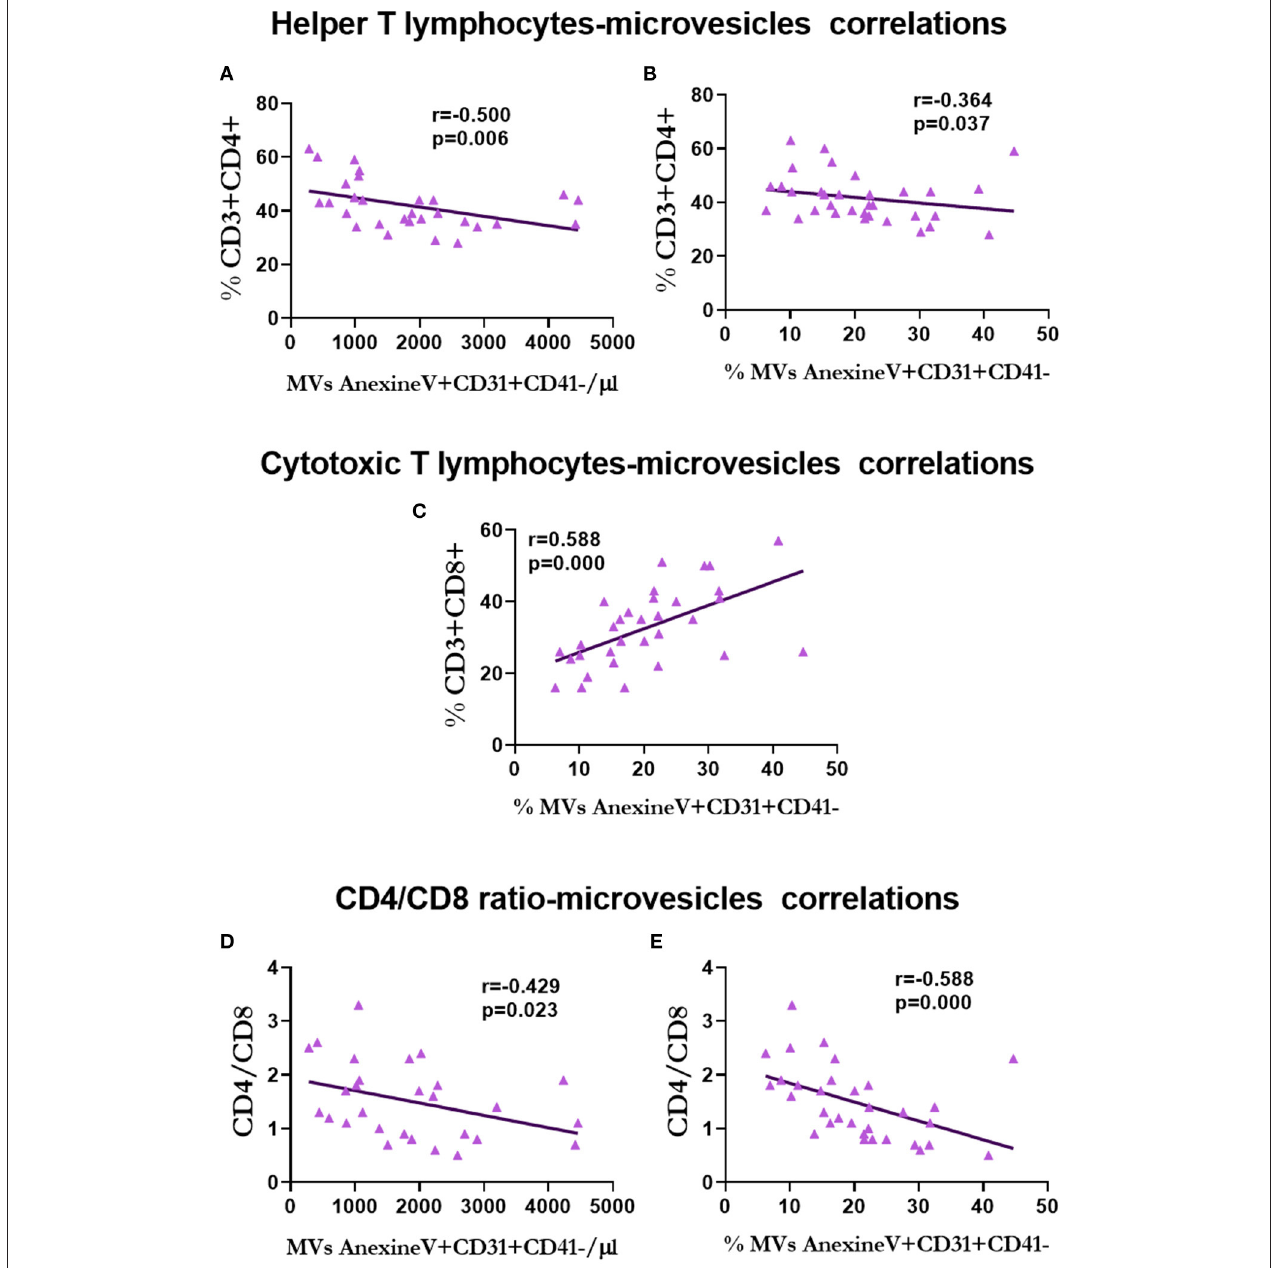
FIGURE 12 | Correlation between lymphocytes and microvesicles in renal transplantation. Correlation between T-helper lymphocytes and the number (A) and percentage (B) of endothelium microvesicles. Correlation between T-cytotoxic lymphocytes and percentage of endothelium microvesicles (C) . Correlation of CD4/CD8 ratio with the number (D) and percentage (E) of endothelium microvesicles.